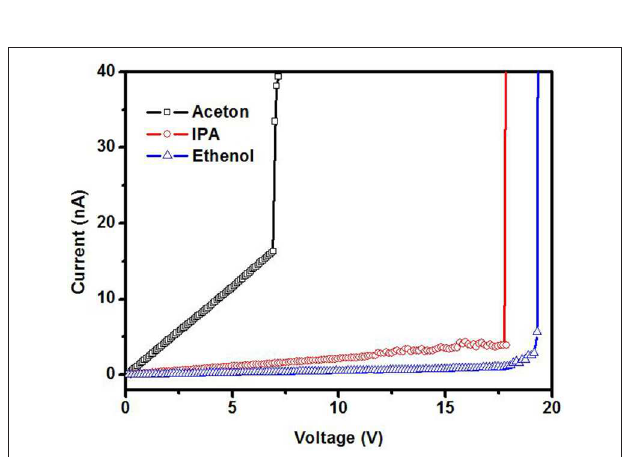
FIGURE 3 | The structural scheme of device. The ZnO nanorods were biased as anode.